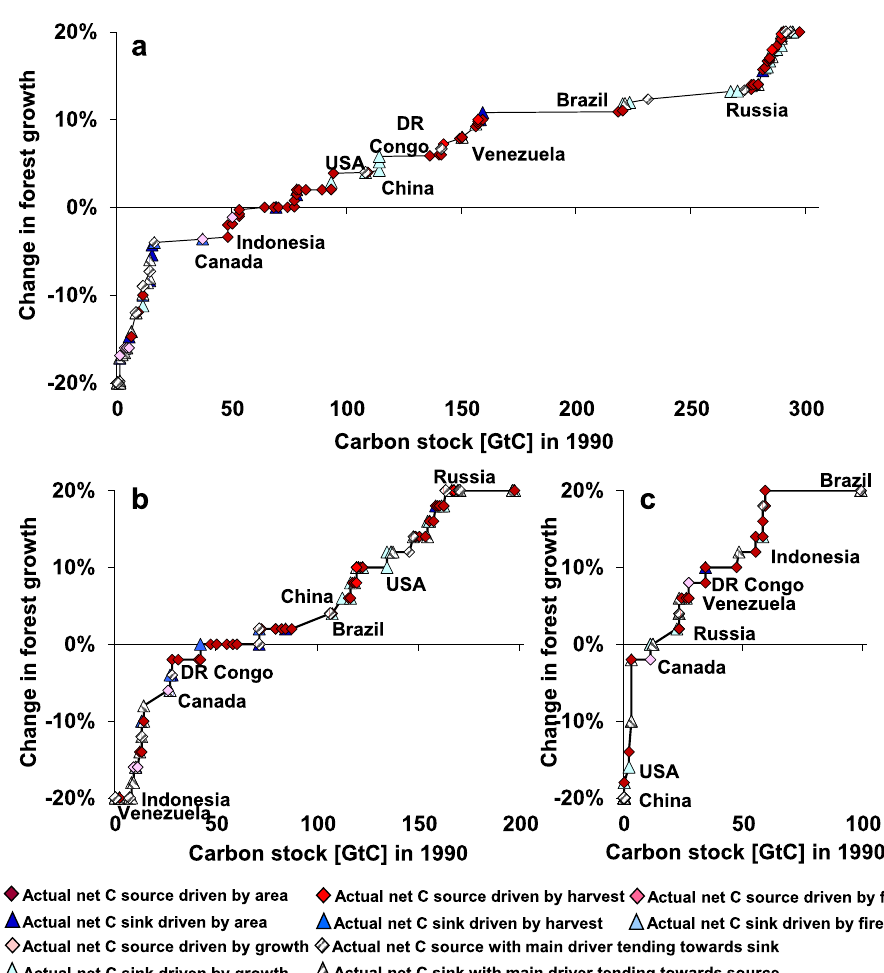
Fig. 4 Change in forest growth rate and its effects on global carbon stocks. The diagrams show national forest growth rate changes ( y -axis) scaled along the cumulated size of the carbon stock in 1990 ( x -axis). The area between the graph and the x -axis indicates the C-stock change due to growth rate for total ( a ), primary ( b ), and managed forests ( c ) (see Supplementary Figs. 8 – 10 for results from sensitivity Methods Principles of the CRAFT model . CaRbon Accumulation in ForesT (CRAFT) is a parsimonious model of long-term changes in carbon (C) stocks and fl uxes in forest ecosystems 16 . CRAFT builds upon the establishment of a place and time-speci fi c relationship between NPP and biomass C stocks and so provides a suitable tool to simulate C-stock dynamics in forest biomass and soils (including both above- ground and belowground biomass). In the present paper, only the biomass module was applied at the national level, distinguishing two key forest categories: primary and managed forest (see de fi nition of the primary versus managed forest below). The input data to simulate C-stock and fl ux dynamics in biomass are wood harvest (tC), extent of burnt area (Mha), primary, and managed forest area (Mha). The main fi xed parameters of the CRAFT model are the mortality rate and the % of losses at cutting, which were taken as 4% and 11%, respectively, based on Liski et al. 59 . The calibration data are the observed data of standing biomass of primary and managed forest at the national level (MtC). From these input and calibration data, we optimized the best growth parameters for each country: r (forest growth rate, yr − 1 ) and K (theoretical maximum carrying capacity, tC ha − 1 ) within a range of possible values (see below). Because the forest growth rate parameter r might be variable over time 9,39,60,61 , we assumed that it may linearly increase or decrease from 1990 to 2020. We considered that the value of the r parameter in 2020 could be in a range between 80% and 120% of its estimated value in 2020. All possible combinations for the r and K values in 1990 and changes in r values in 2020 were tested at the national level by steps of 0.01yr − 1 , 20tC ha − 1 , and 2%, respectively, representing 11,160 possibilities for managed and primary forests of each country. These optimizations were performed with a routine using Macros in Microsoft excel so that simulated data best fi t the available observed data within the CRAFT model. At the global level, we calculated forest growth rate values of 0.07, 0.10, and 0.09yr − 1 in 1990 and estimated that these values increased annually by 0.19%, 0.21%, and 0.21% until 2020, respectively, for primary, managed, and total forests of the world.